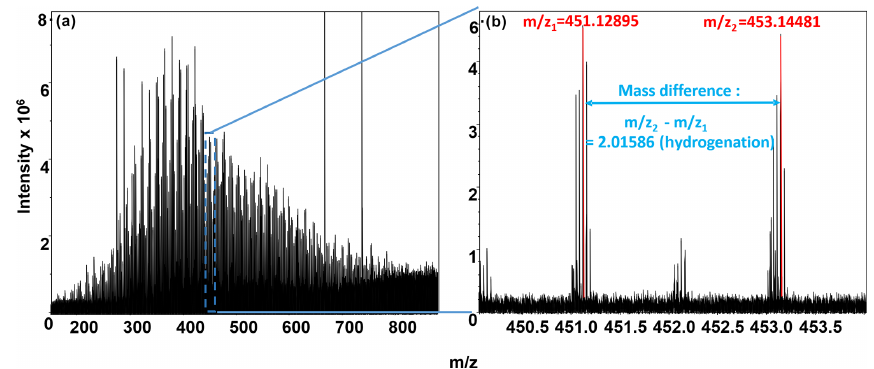
Figure 2. (a) Negative-mode FTICR-MS (full spectrum); (b) magnification at m/z ∼ 450, showing an example of our FTICR-MS spectra, overlain with peak mass assignments (red), and a biochemical transformation (mass difference between peaks; denoted in blue). y axis denotes peak intensities, and x axis denotes mass-to-charge